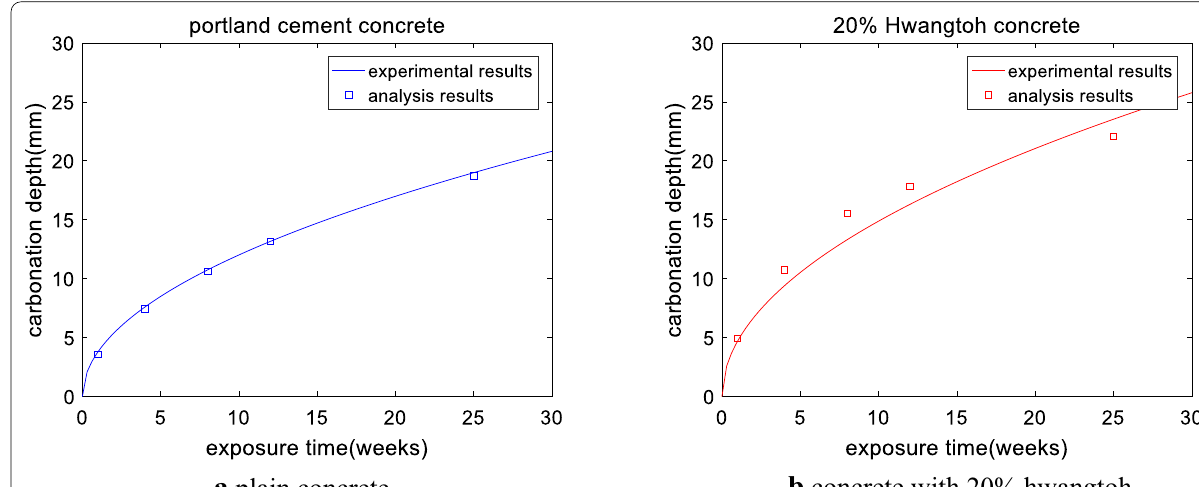
Fig. 10 Carbonation depth of hwangtoh‑blended concrete (Lin et al. 2019).